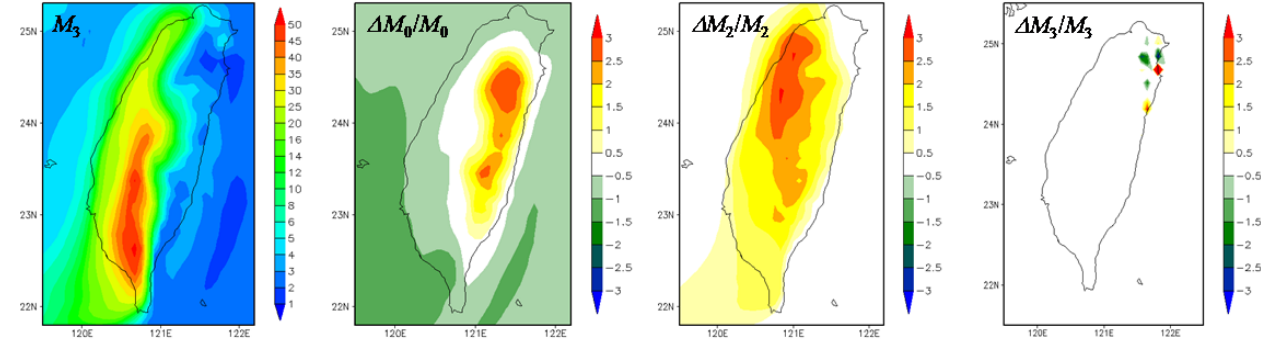
Fig. 14. Left: simulated aerosol mass loading over the Taiwan area using SNAP for Brownian coagulation in the CMAQ model. Other panels from left to right: percentage difference between SNAP and GHQ in M 0 , M 2 and M 3 .